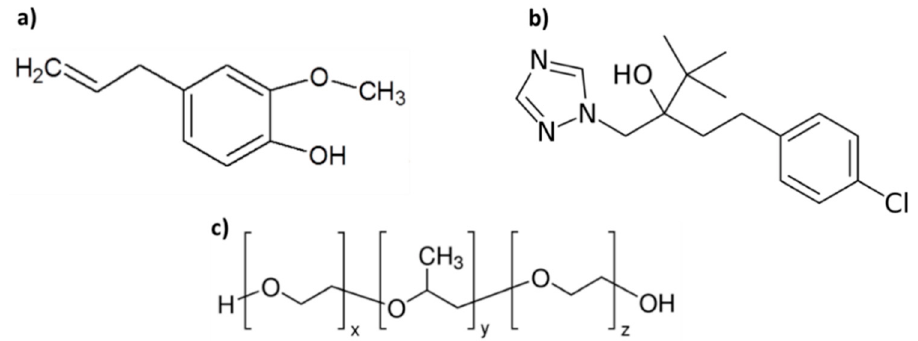
Figure 1. Chemical structures for eugenol ( a ), Tebuconazole ( b ) and poloxamer 407 with x = z = 101 and y = 56 ( c ).